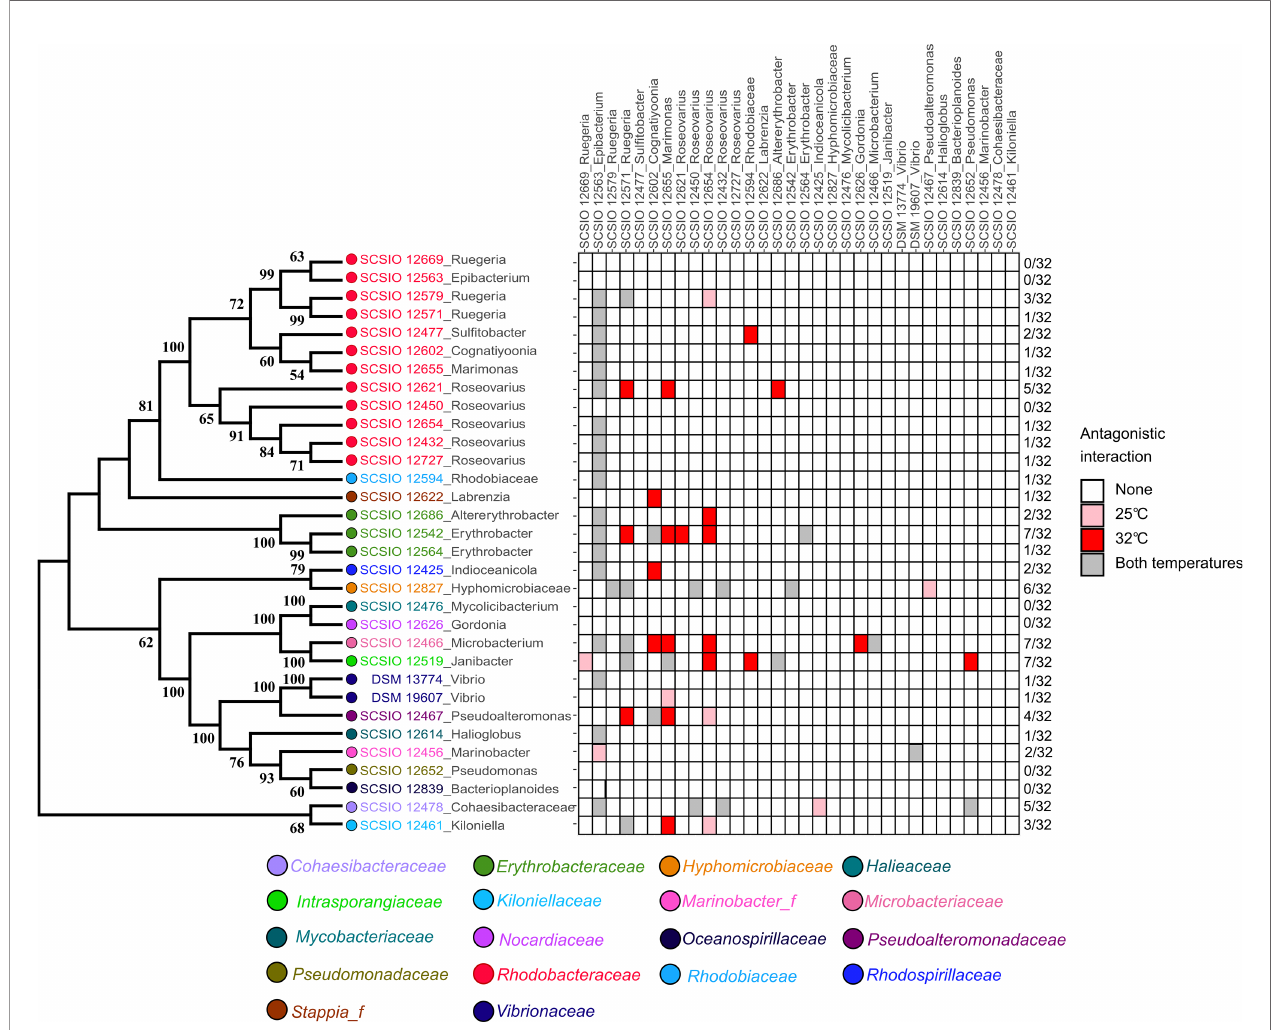
FIGURE 2 | Heat map of the antagonistic interactions among the coral-associated bacteria integrated with a phylogenetic tree. Isolates listed on the top of the heatmap are producers, and those listed on the left side are inhibited. Colors of the strains numbers represent the taxonomic information at the family level. The number of antagonistic interactions and the sum for each row were presented on the right side of the heatmap. Pink and red blocks indicate antagonism at 25°C and 32°C, respectively. The gray block represents antagonism at both